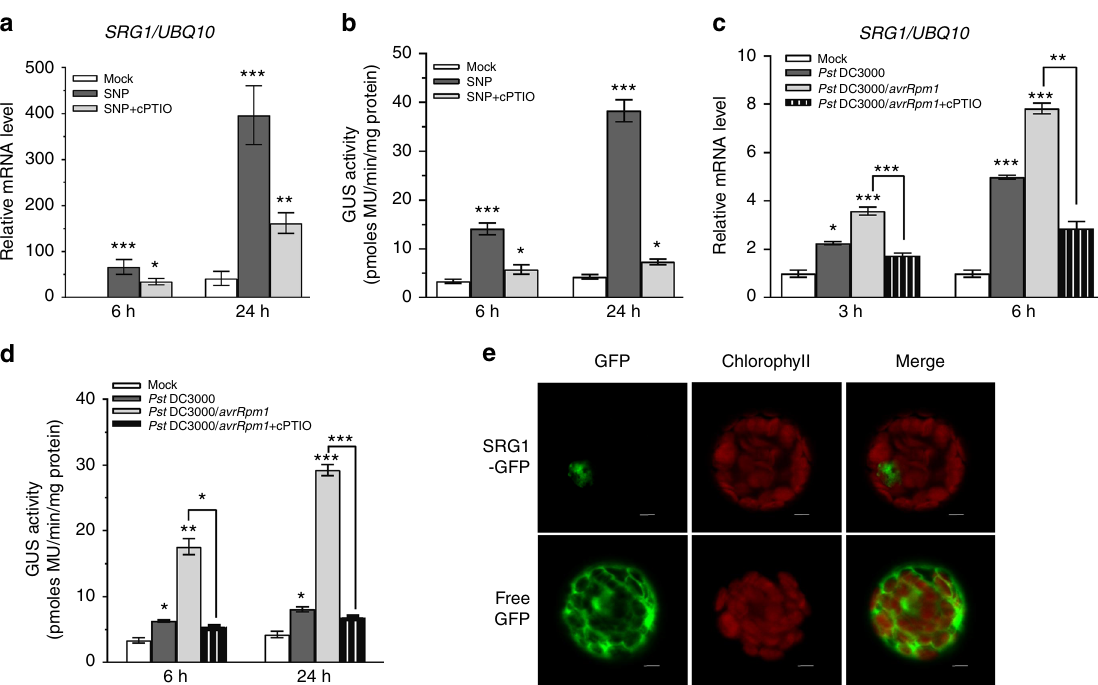
Fig. 1 SRG1 expression is regulated by nitric oxide. a Transcript levels of SRG1 were determined following treatment with the nitric oxide (NO) donor, sodium nitroprusside (SNP), either alone or in combination with the NO scavenger 2-4-carboxyphenyl-4,4,5,5-tetramethylimidazoline-1-oxyl-3-oxide (cPTIO). b β -glucuronidase (GUS) activity upon SNP treatment of SRG1 :: GUS lines. GUS activity in the given SRG1::GUS line in response to SNP (300 μ M) and SNP plus cPTIO (200 μ M) was analyzed by a GUS activity assay. c Quantitative real time polymerase chain reaction (qRT-PCR) to quantify SRG1 gene expression post treatment with Pseudomonas syringae pv tomato DC3000 or Pst DC3000 expressing avrRpm1 in the presence or absence of cPTIO. d GUS activity assay of SRG1::GUS lines post treatment with either Pst DC3000 or Pst DC3000( avrRpm1 ) in the presence or absence of cPTIO. e Subcellular localization of SRG1-green fl uorescent protein (GFP) and free GFP were analysed in Arabidopsis protoplasts using a confocal microscope. Scale bar, 5 μ m. Error bars represent mean ± standard deviation (SD) ( n = 3 independent experiments). Asterisks indicate a signi fi cant difference from mock (student t -test, *** P < 0.001, * P <